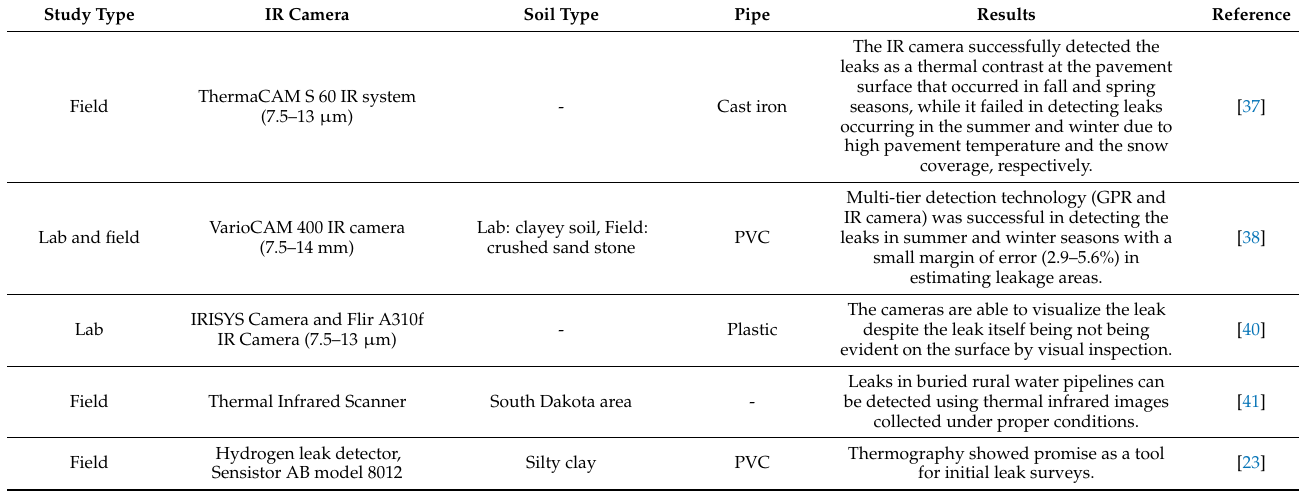
Table 4. Studies using IR cameras for water leak